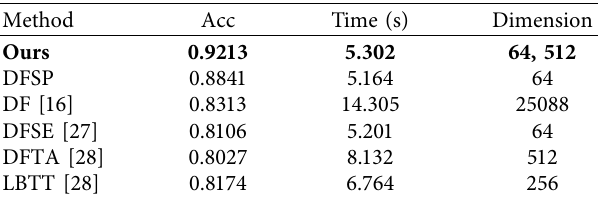
Table 6: Comparison with existing visual search approaches on the 2001 TREC